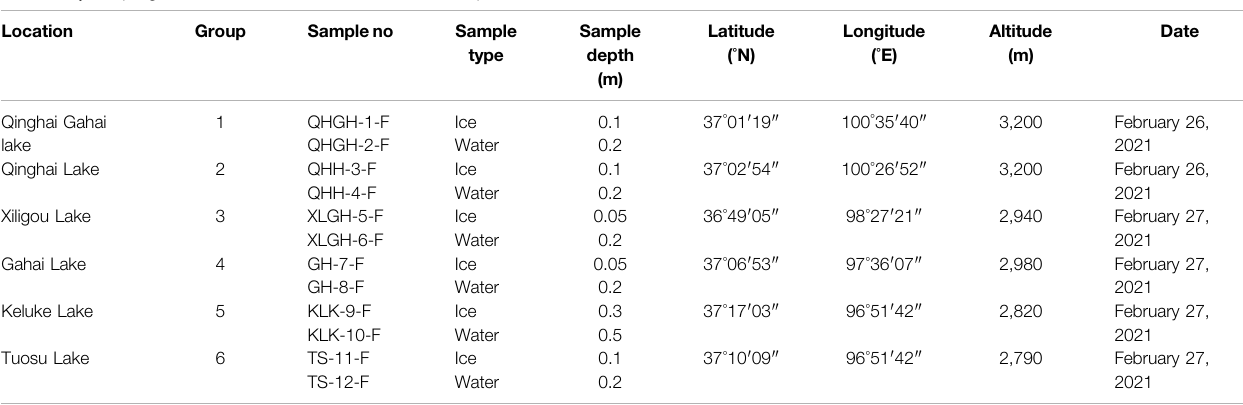
TABLE 1 | Sampling site information for the ice and water